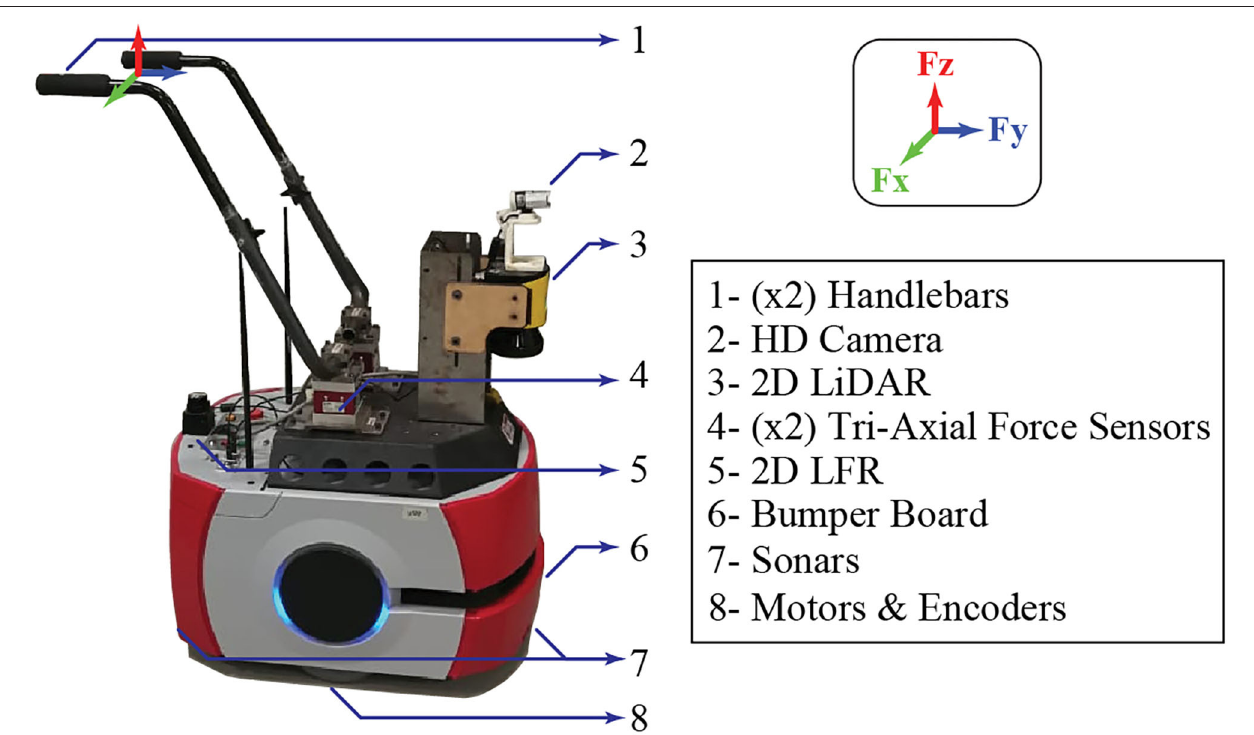
FIGURE 1 | AGoRA Smart Walker (SW)